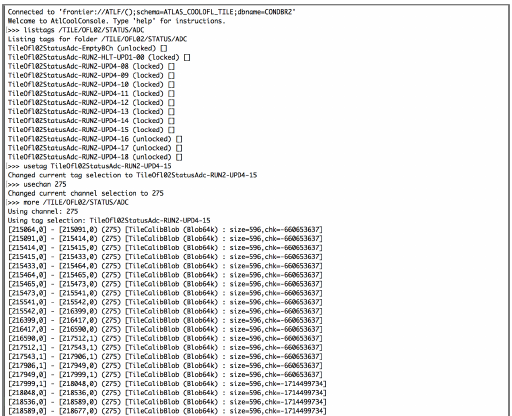
Fig. 3. Example structure of TileCal DB folder, with tags and